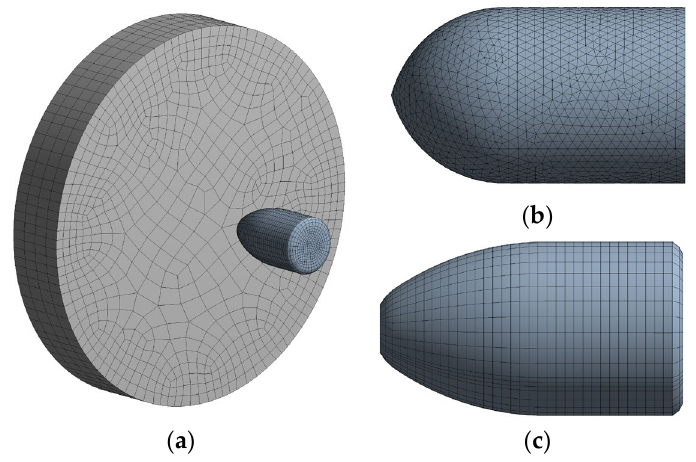
Table 4. Projectile initial condition.